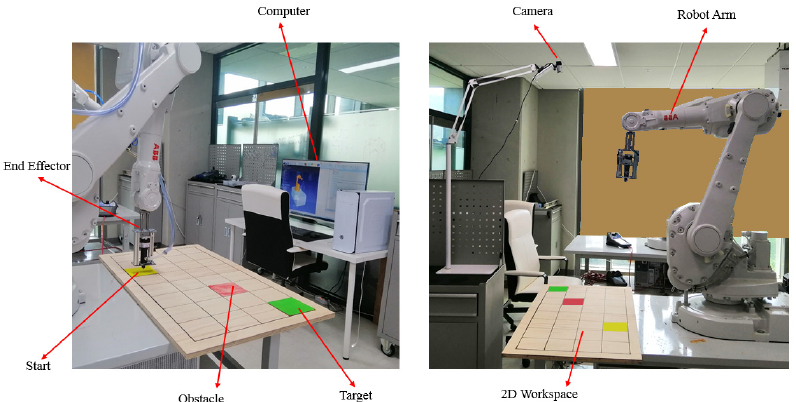
Figure 7. Experimental setup: camera, robot arm, workspace, yellow start, red obstacle, green target, computer.